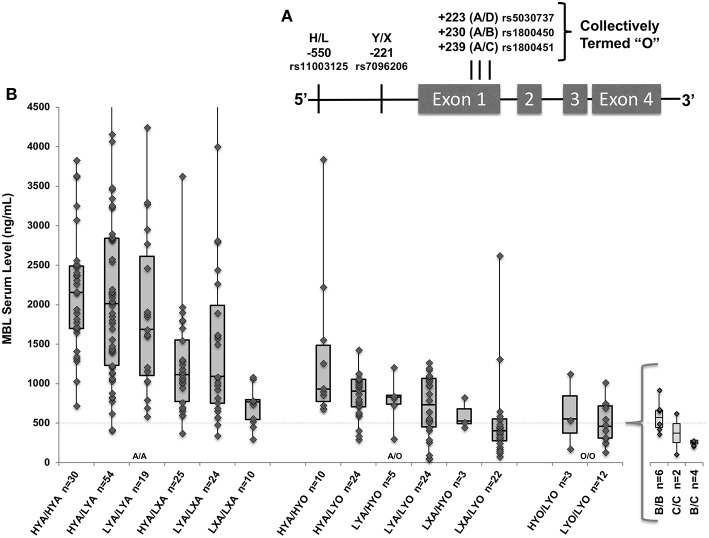
(A)
MBL2 gene with known low-producer variant polymorphisms. Marked positions denote promoter variants H/L and Y/X, and exon 1 variants “B,” “C,” and “D” (collectively termed “O”). (B) The gene-to-level analysis (n = 265) included all genotyped patients who also had measured MBL levels. Box and whisker plots indicate serum level quartiles: 1st quartile (bottom line) 2nd/3rd quartile (box) with median at line, and 4th quartile (top line). MBL2 haplotypes combined into diplotypes with associated serum MBL levels (n = number of patients included); wild type (A/A), heterozygote (A/O), and homozygotes (O/O) with additions of low-producing promoters from left-to-right within each X-axis group. Specific variants within LYO/LYO homozygotes are shown in insert; there were not significant differences in levels among B/B, C/C, and B/C homozygotes. Four patients (3 HYA/LYA, 1 LYA/LXA) had values > the Y axis set maximum of 4,500 ng/mL. Dashed line indicates 500 ng/mL throughout.